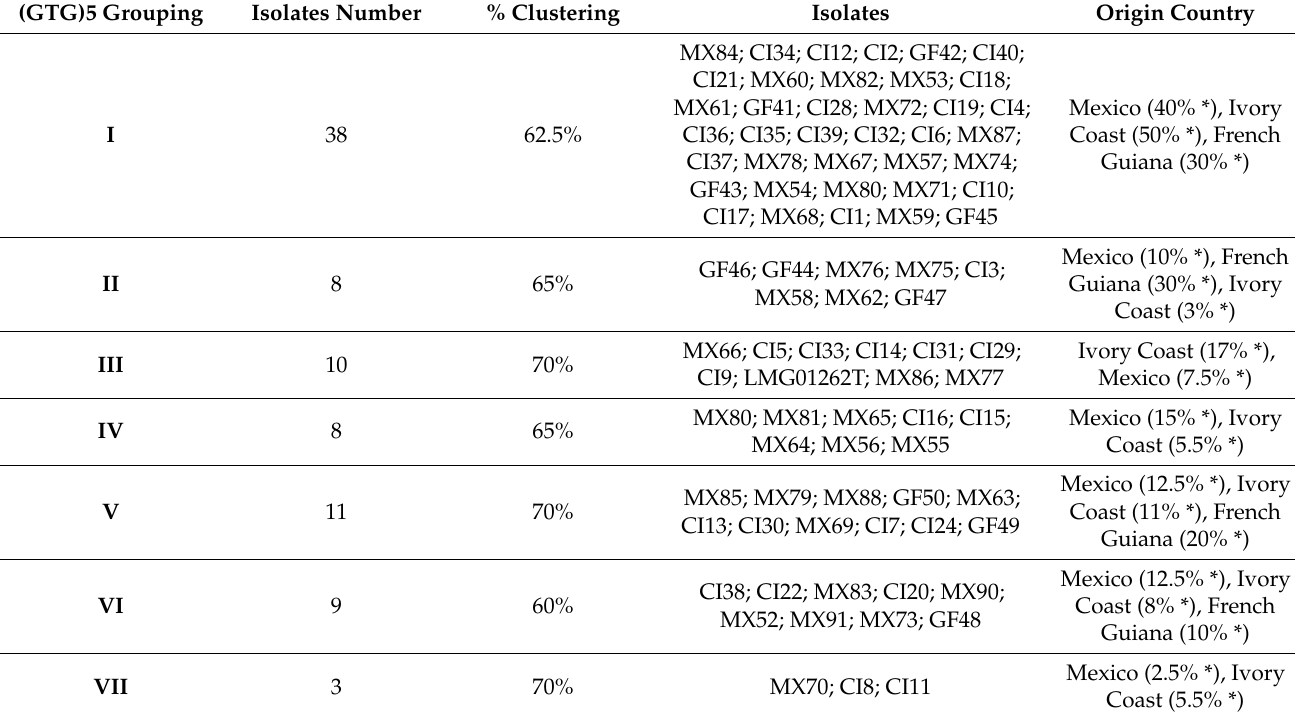
Table 4. Clustering of A. pasteurianus strains according to the genomic polymorphism analysis by (GTG) 5